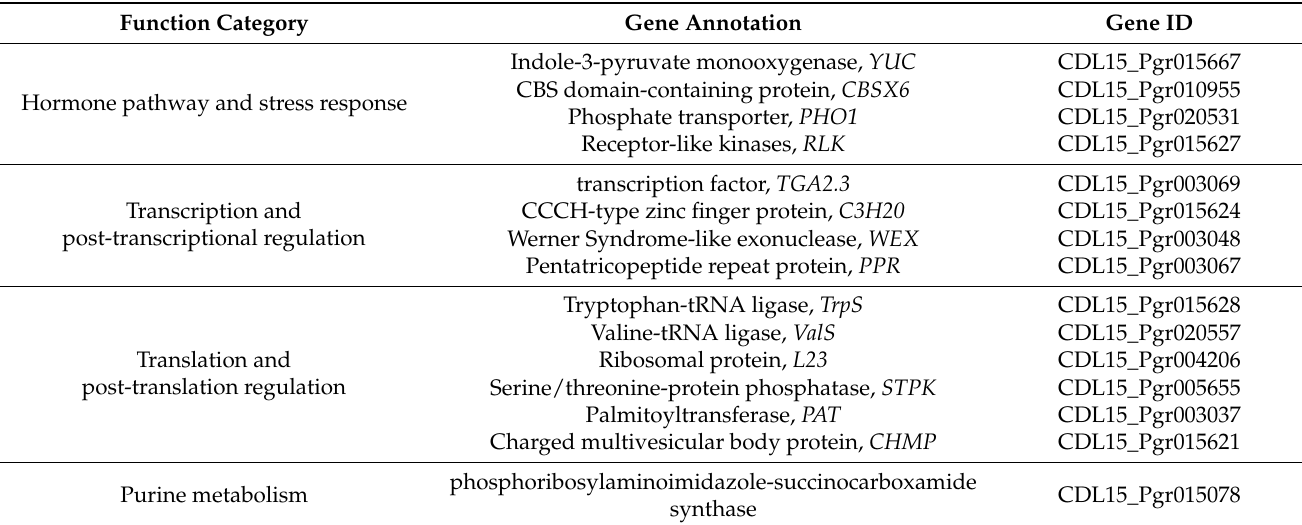
Table 5. Classification of variant genes between single- and double-petal